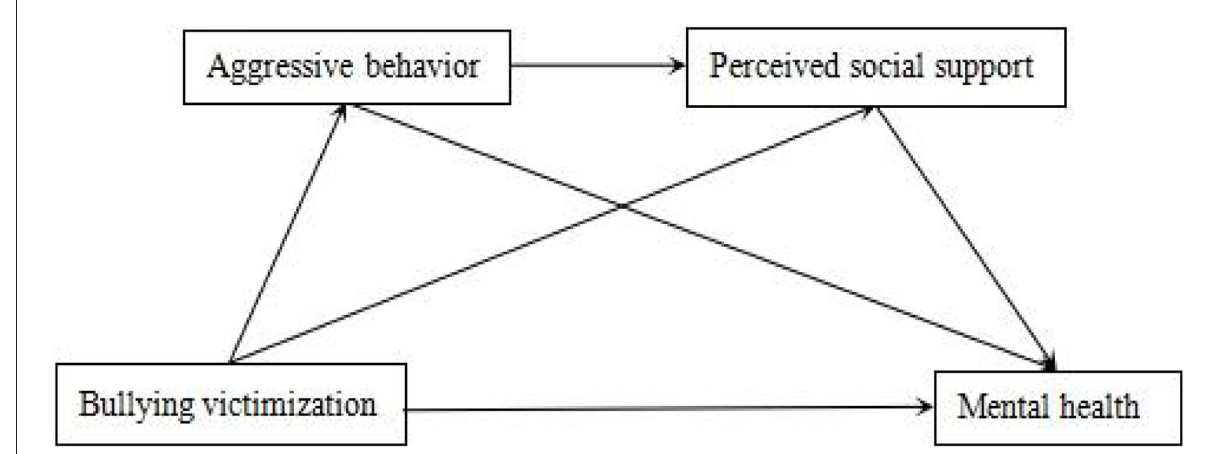
FIGURE1 Relationship path map of bullying victimization, aggressive behavior, perceived social support, and mental health.